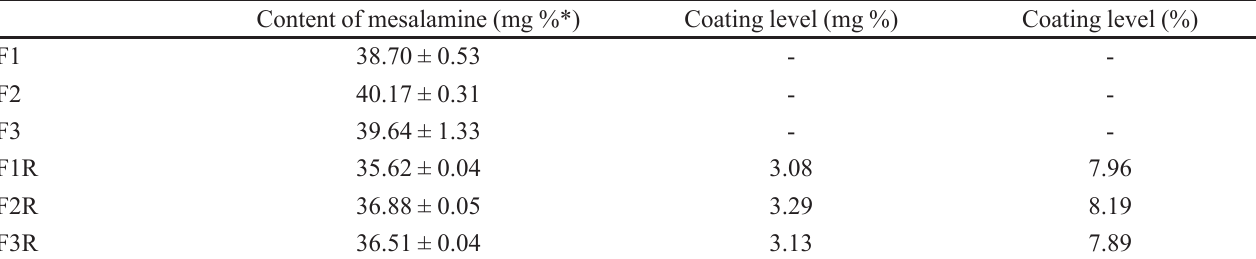
TABLE II – Content of mesalamine and coating